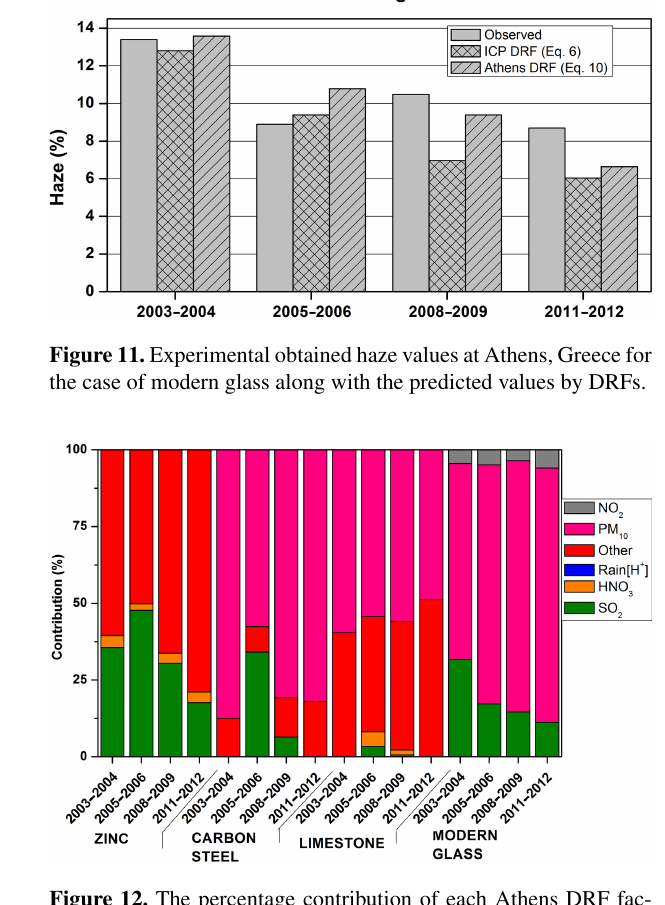
Figure 12. The percentage contribution of each Athens DRF fac- tor to the total corrosion/soiling of each material for all exposure